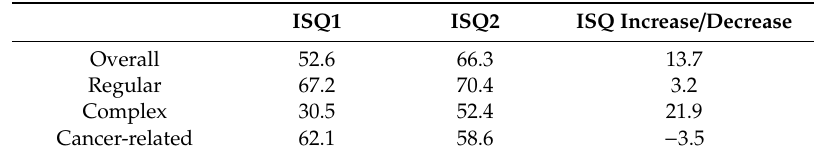
Table 5. Implant stability quotient (ISQ) measurement score at implant placement and secondary surgery in overall, regular, complex, and cancer-related sites.